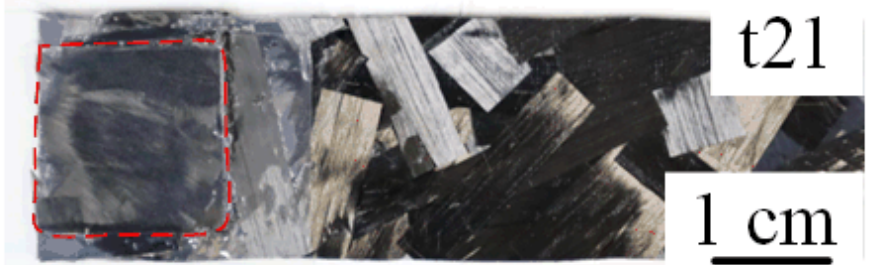
Figure 22. Representative fracture surface of category 3.